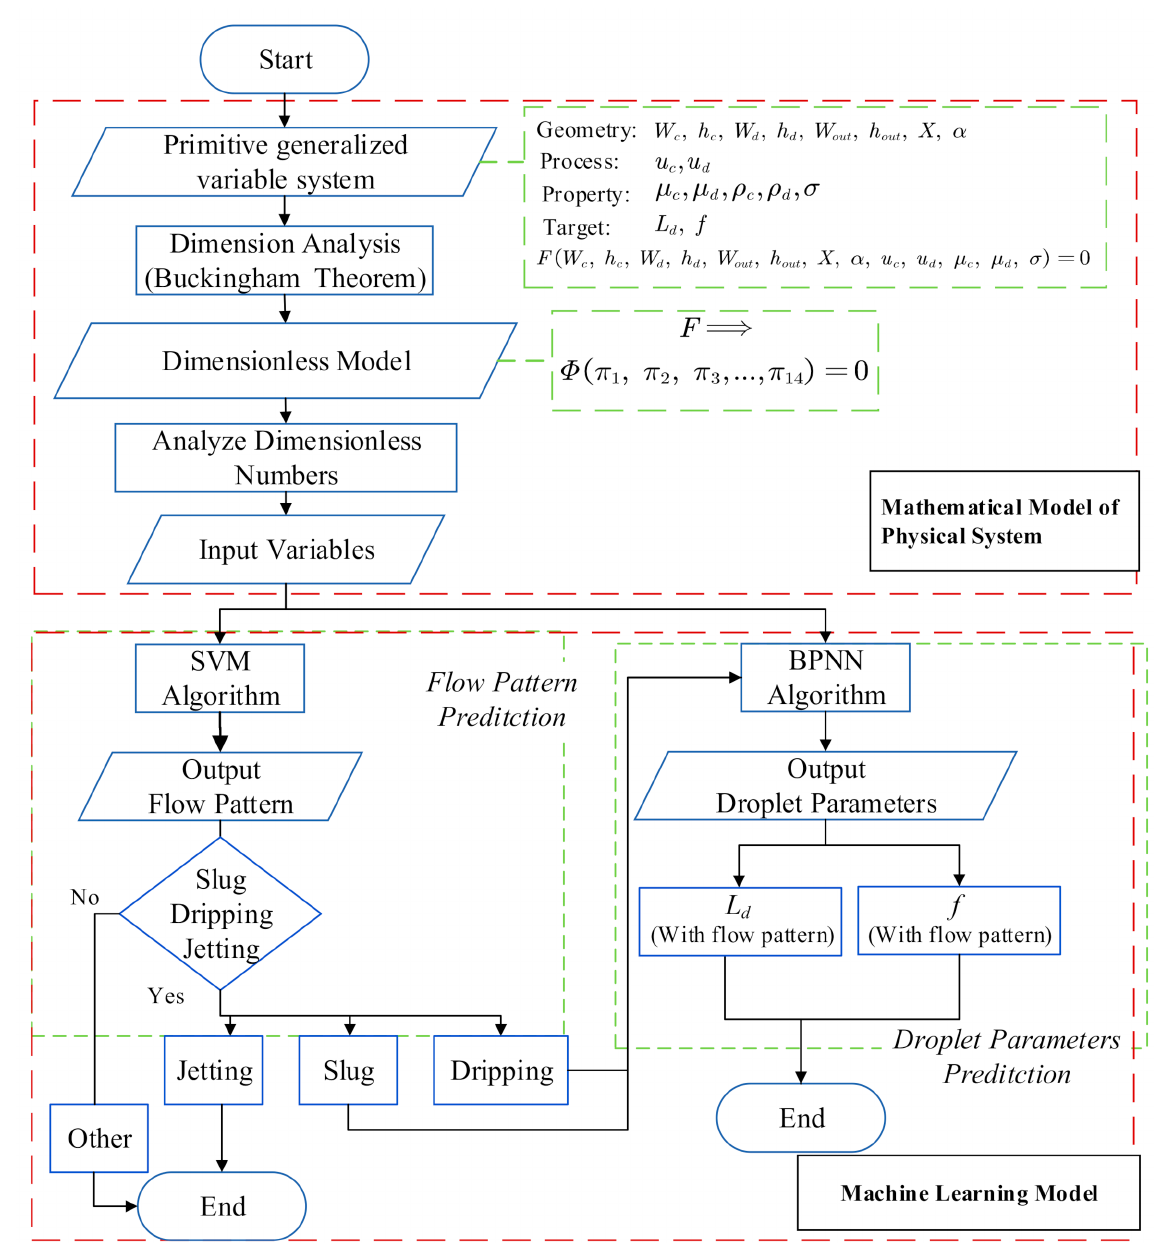
Figure 1. Flow chart of machine learning